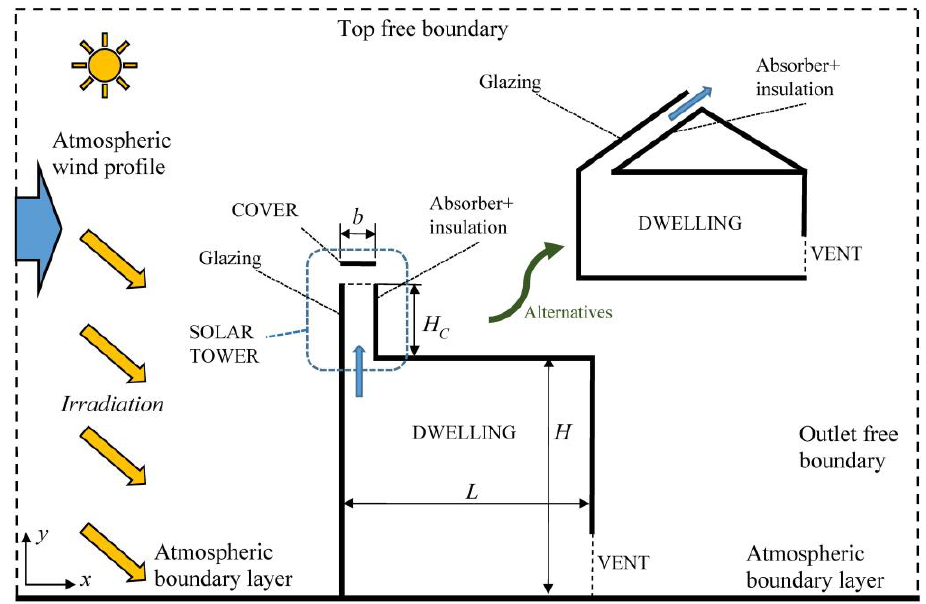
Figure 5. General scheme of a rooftop solar chimney for ventilation purposes. On the right, an al- ternative configuration for inclined roof is